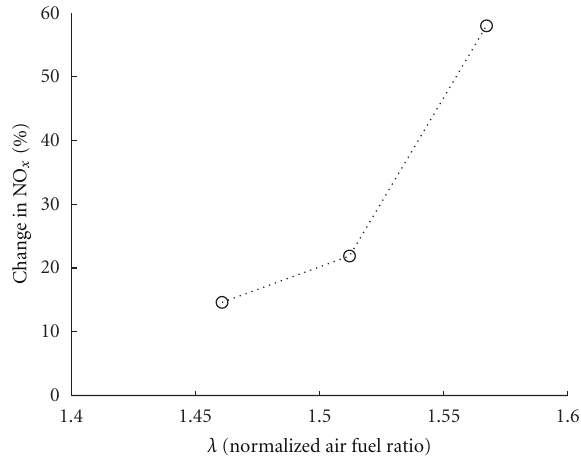
Figure 6: The percent change in NO x emissions with 1600 mJ microwave-enhanced ignition from NO x emissions with spark-only ignition. Under stable operating conditions ( λ = 1 . 46), addition of microwave energy increases NO x production by 13% ( ∼ 100 ppm). Increasing λ further increases NO x .